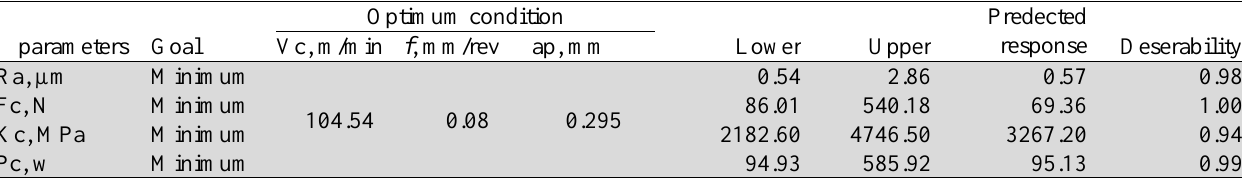
Fig. 16. Response optimization plots for (Ra, Fc, Kc and Pc) Response optimization for